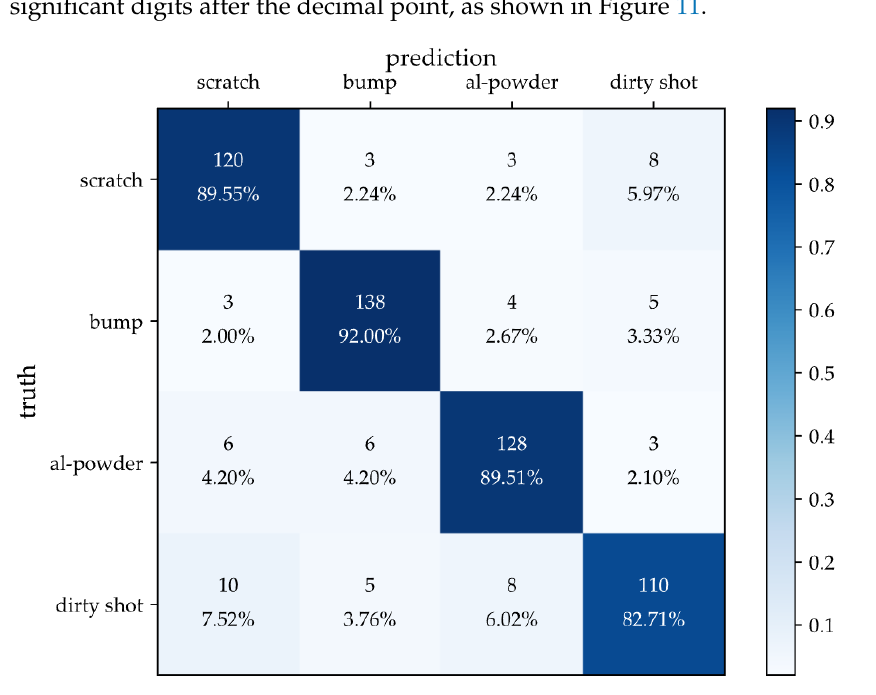
Figure 11. Normalized confusion matrix of four categories.